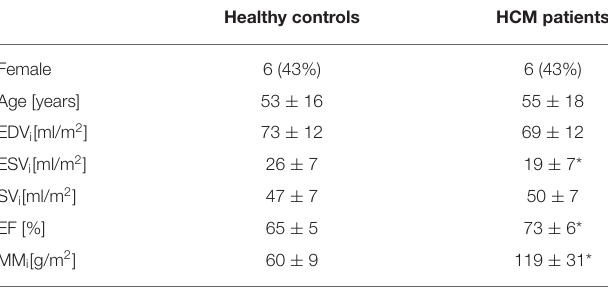
TABLE 3 | Baseline characteristics of HCM patients and matched healthy controls.